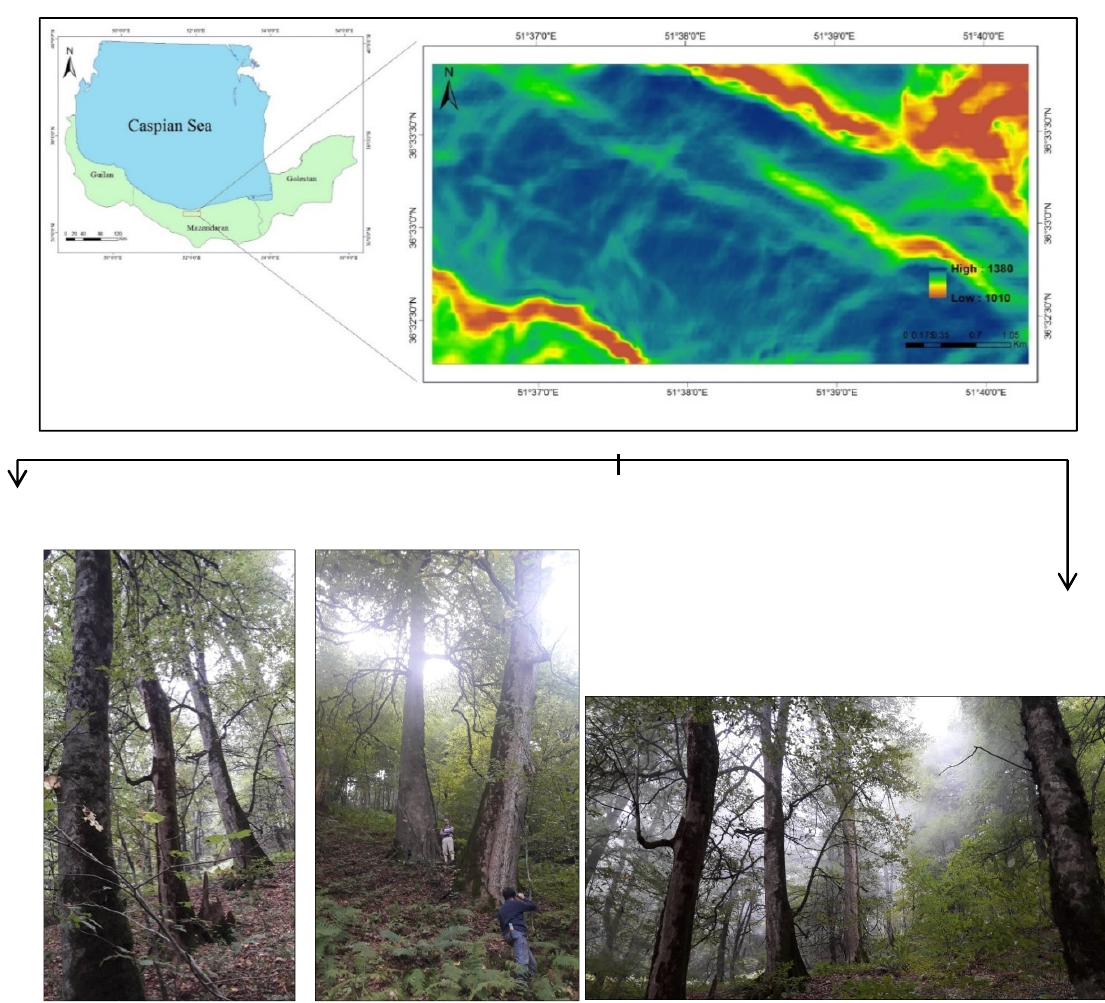
Figure 1. Location and example conditions of the study area.